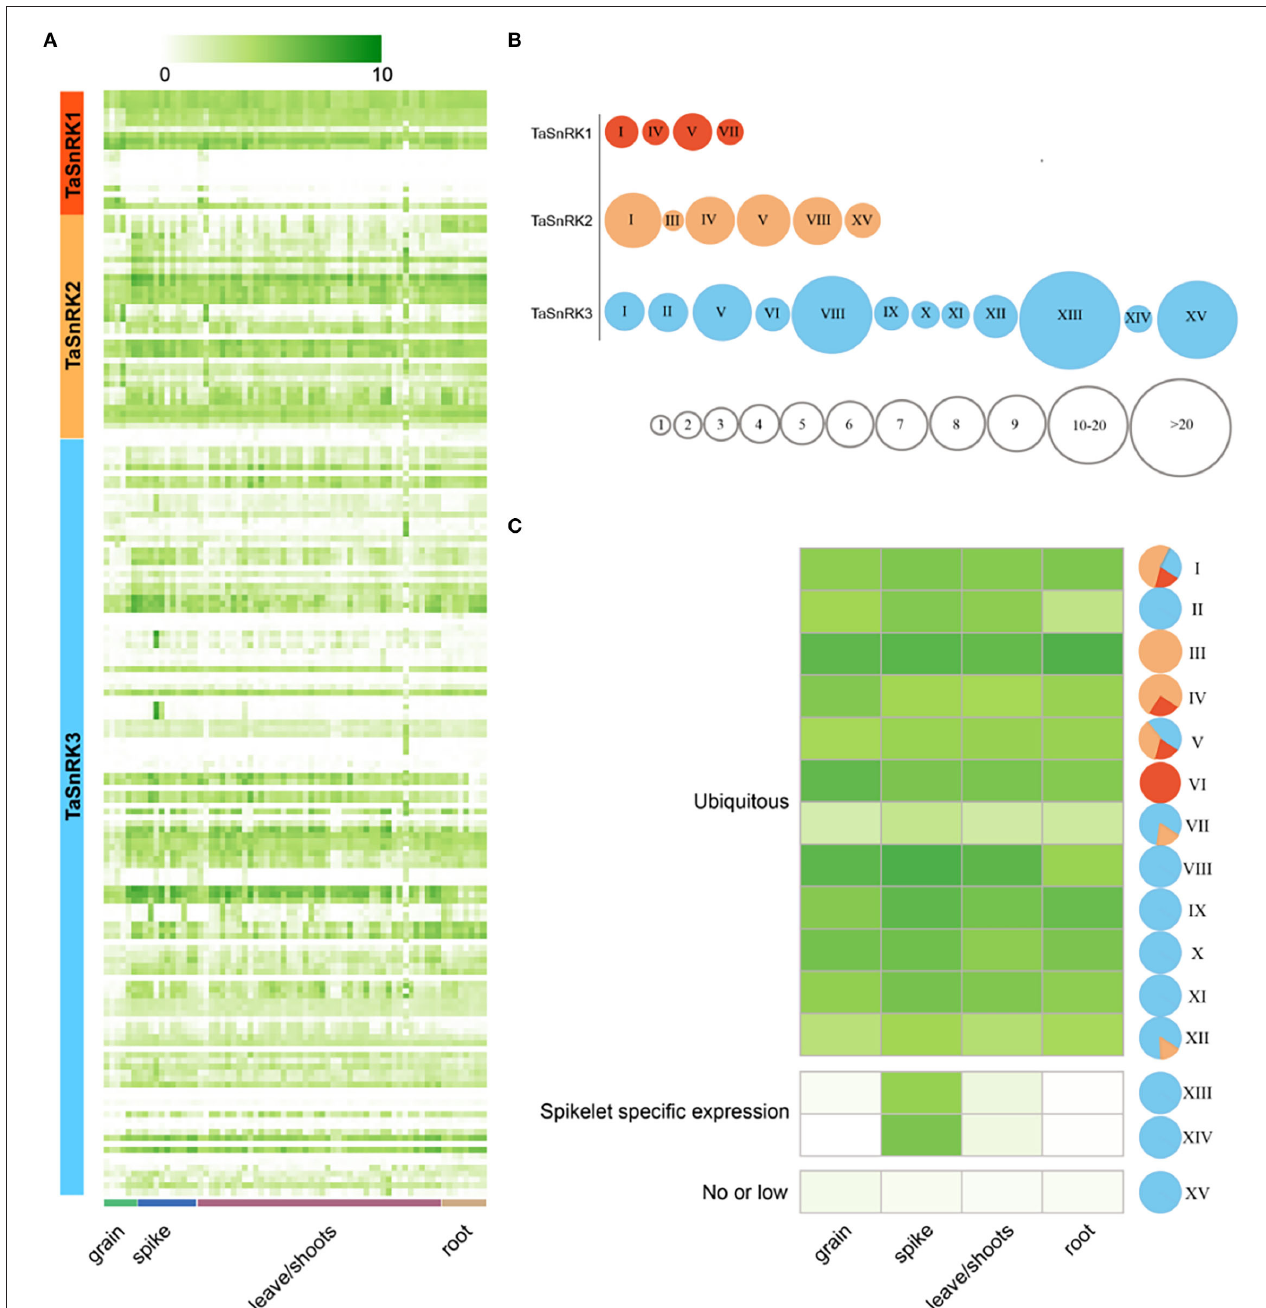
FIGURE 4 | Transcriptome analyses of 186 TaSnRKs during wheat development. (A) The 186 TaSnRK gene expression levels in three wheat development stages/tissues (columns) and subfamilies (rows). Different levels of gene fold change, i.e., log2 (TPM + 1), are marked by colors that gradually change (Fold change > 5 suggests significant expression). Detailed information is listed in Supplementary Material 7 . (B) Based on the gene expression, genes in three subfamilies were clustered into 15 types indicated by roman numerals. Smaller circles indicate fewer genes of this subfamily belong to this type (a particular circle size suggests gene numbers). (C) A heatmap shows average expression values for the 15 types. Colors in sectors indicate three subfamilies as (A,B) : SnRK1 (red), SnRK2 (orange), and SnRK3 (blue).